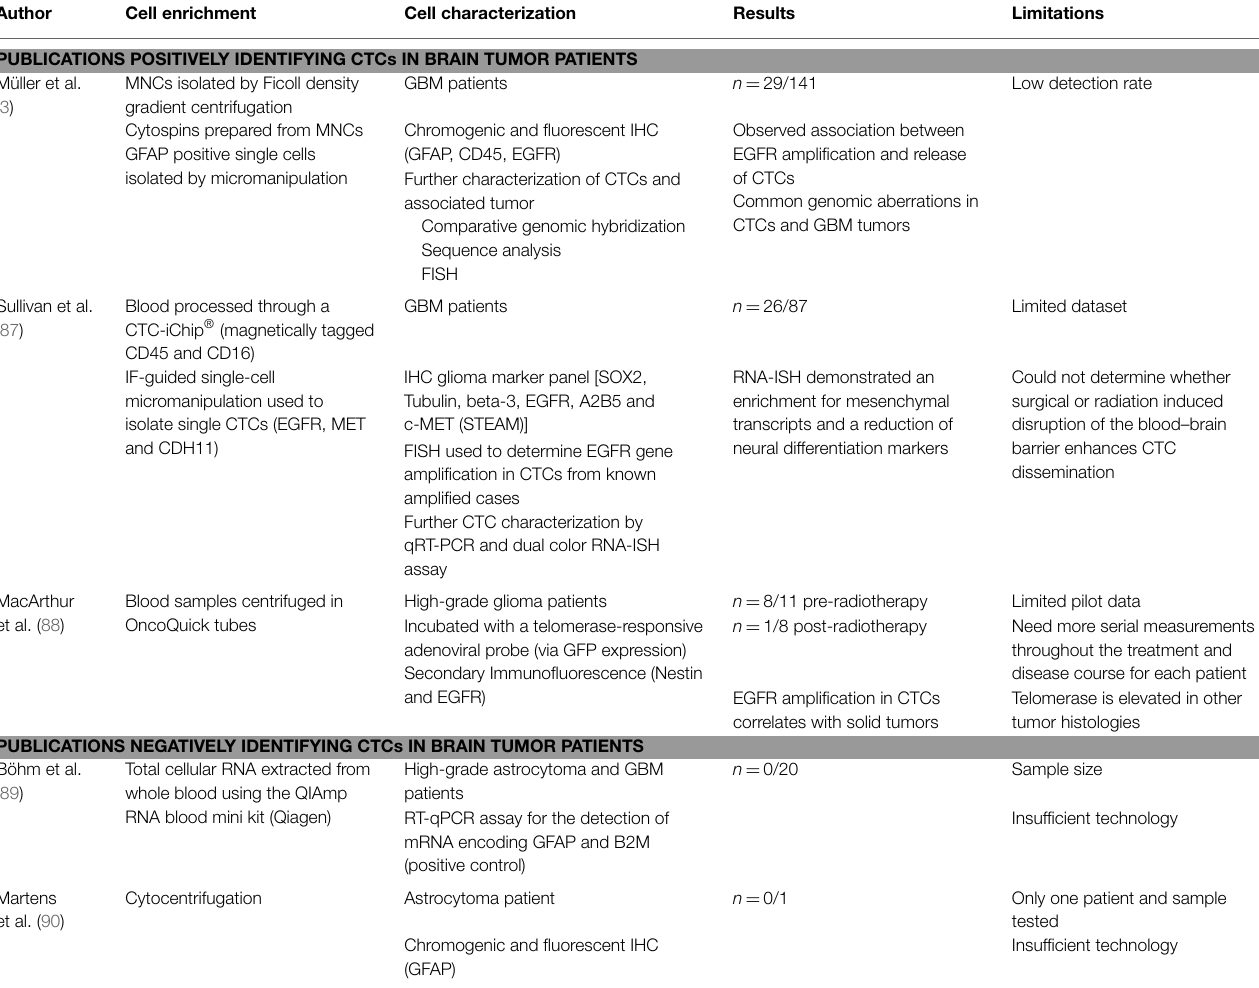
TABLE 1 | Summary of studies attempting to isolate CTCs from patients with high-grade gliomas